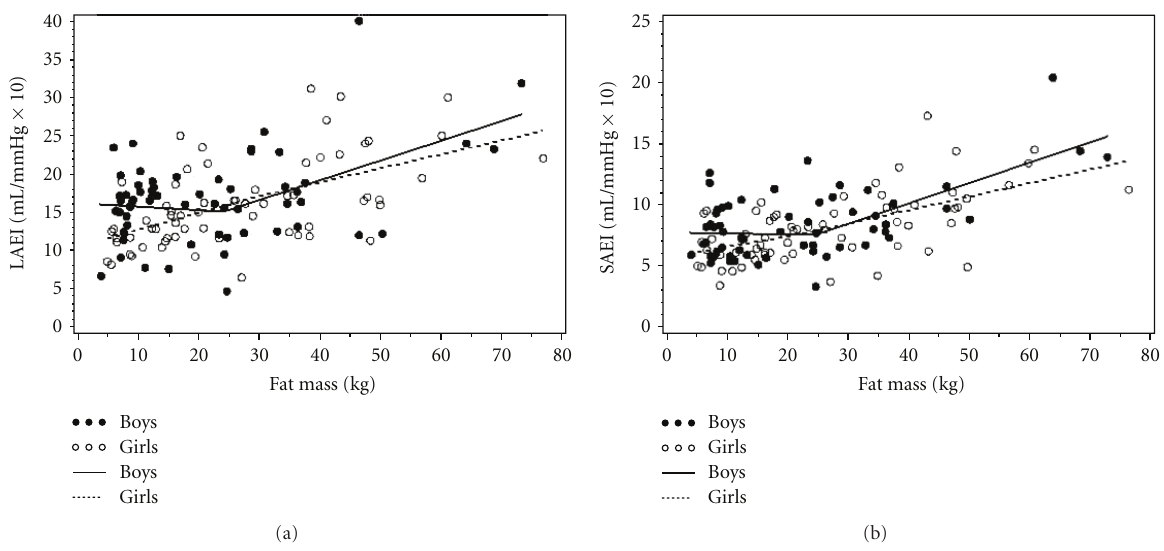
Figure 2: Association between total body fat mass and large arterial elasticity index (LAEI (a) and SAEI (b), resp.) in boys and girls. SAEI and LAEI were positively associated with fat mass in girls in a continuous fashion, while in boys, it was only positively associated with SAEI and LAEI after approximately 24kg of fat